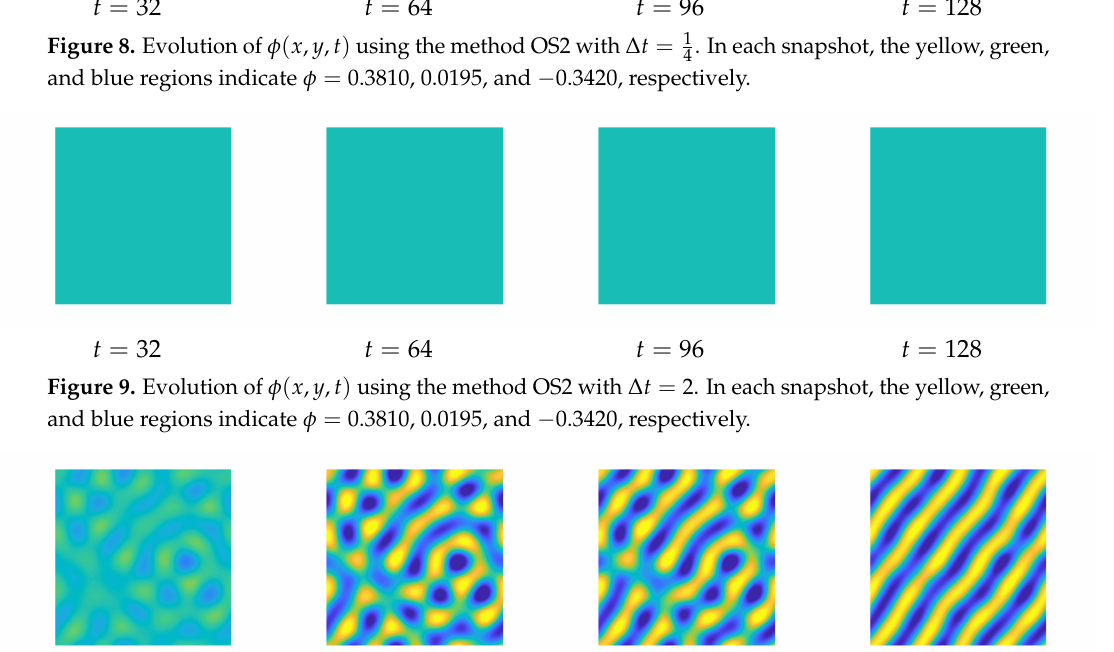
Figure 10. Evolution of φ ( x , y , t ) using the method S2 with ∆ t = 1 and blue regions indicate φ = 0.3810, 0.0195, and